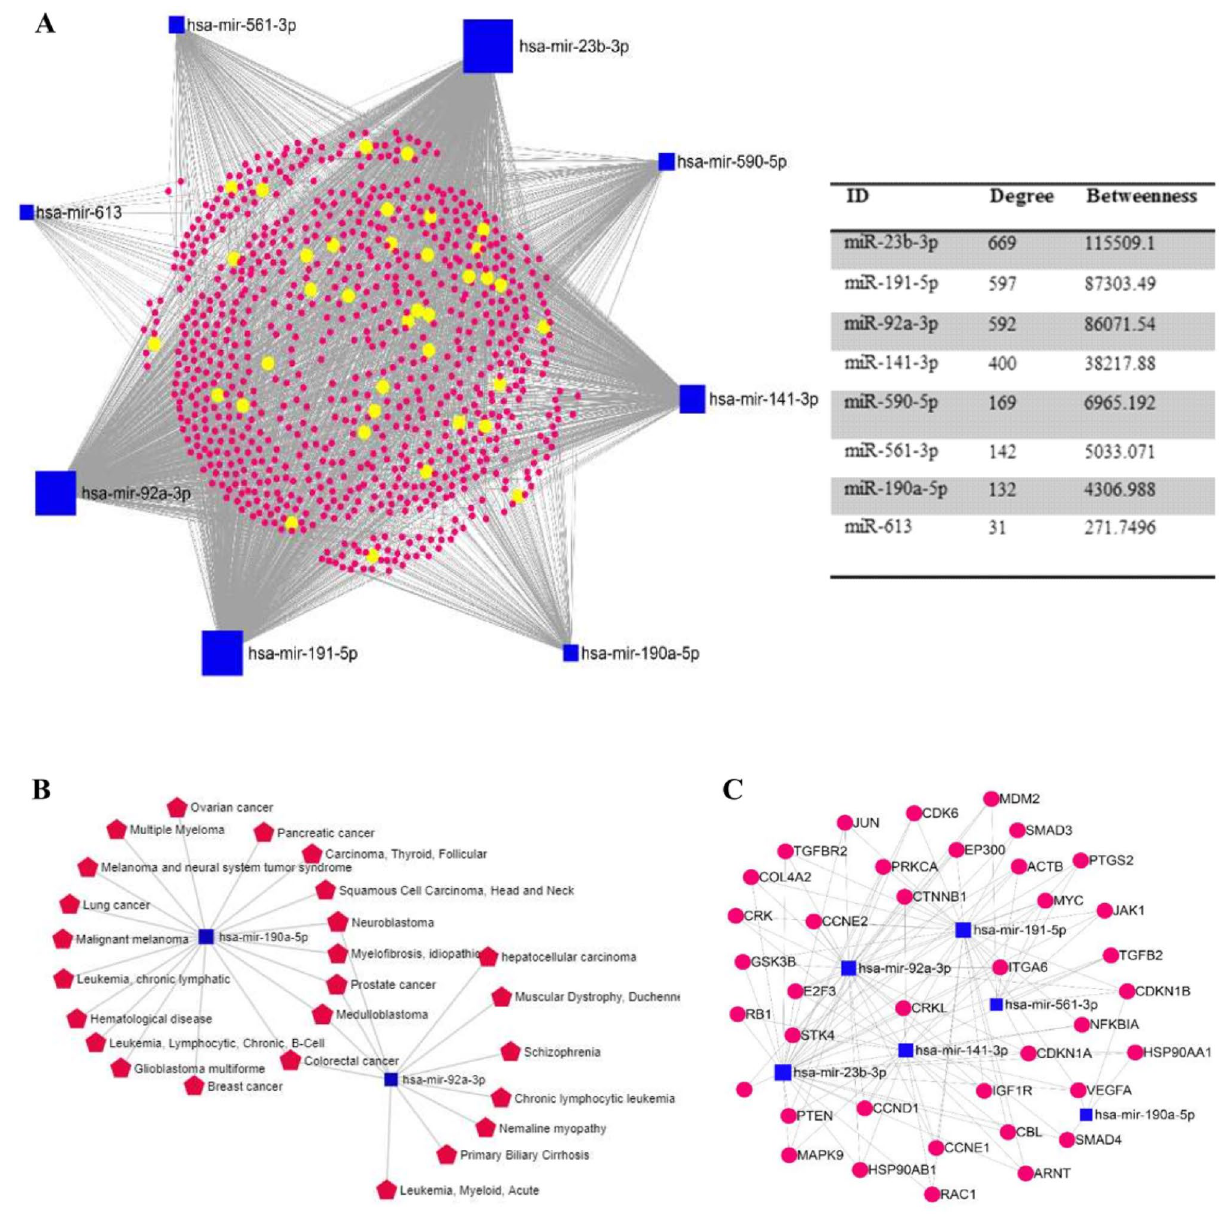
Figure 3. ( A ) The miRNA-gene interaction network of the eight predicted miRNA biomarkers ( B ) miRNA- disease interaction network of the eight candidate biomarkers. ( C ) Genes involved in cancer-related pathways, extracted from miRNA-gene interaction